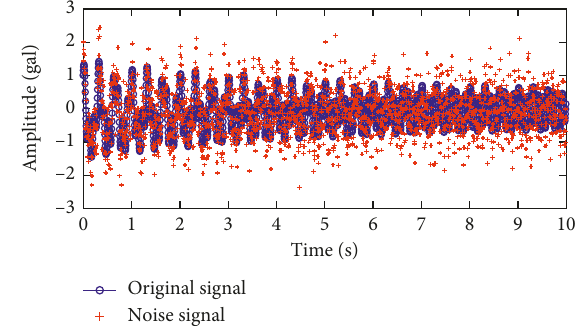
Figure 2: Comparison figure of original signal and noise signal.